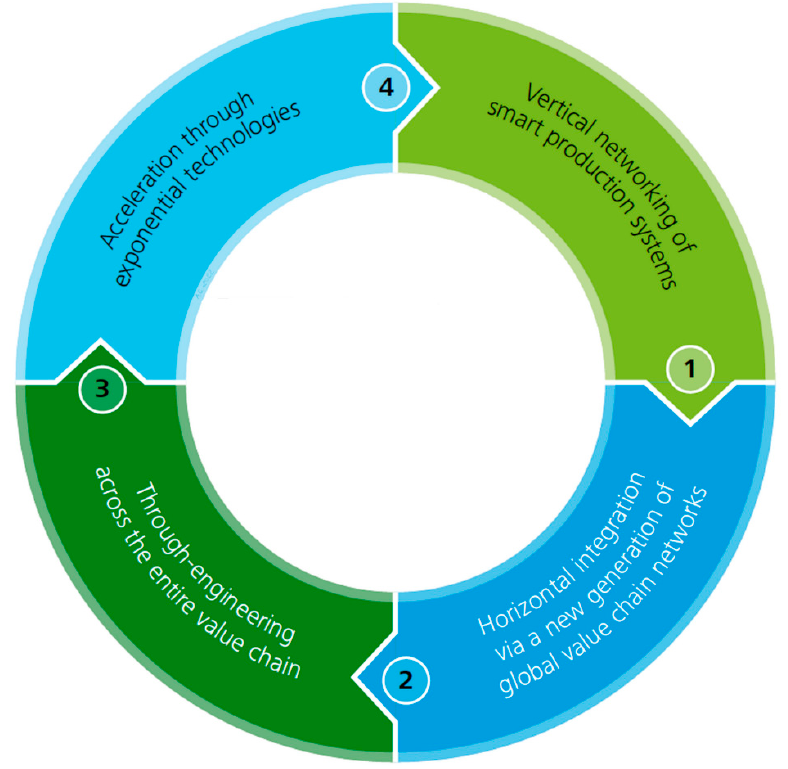
Figure 3. Elements of Industry 4.0 [26].